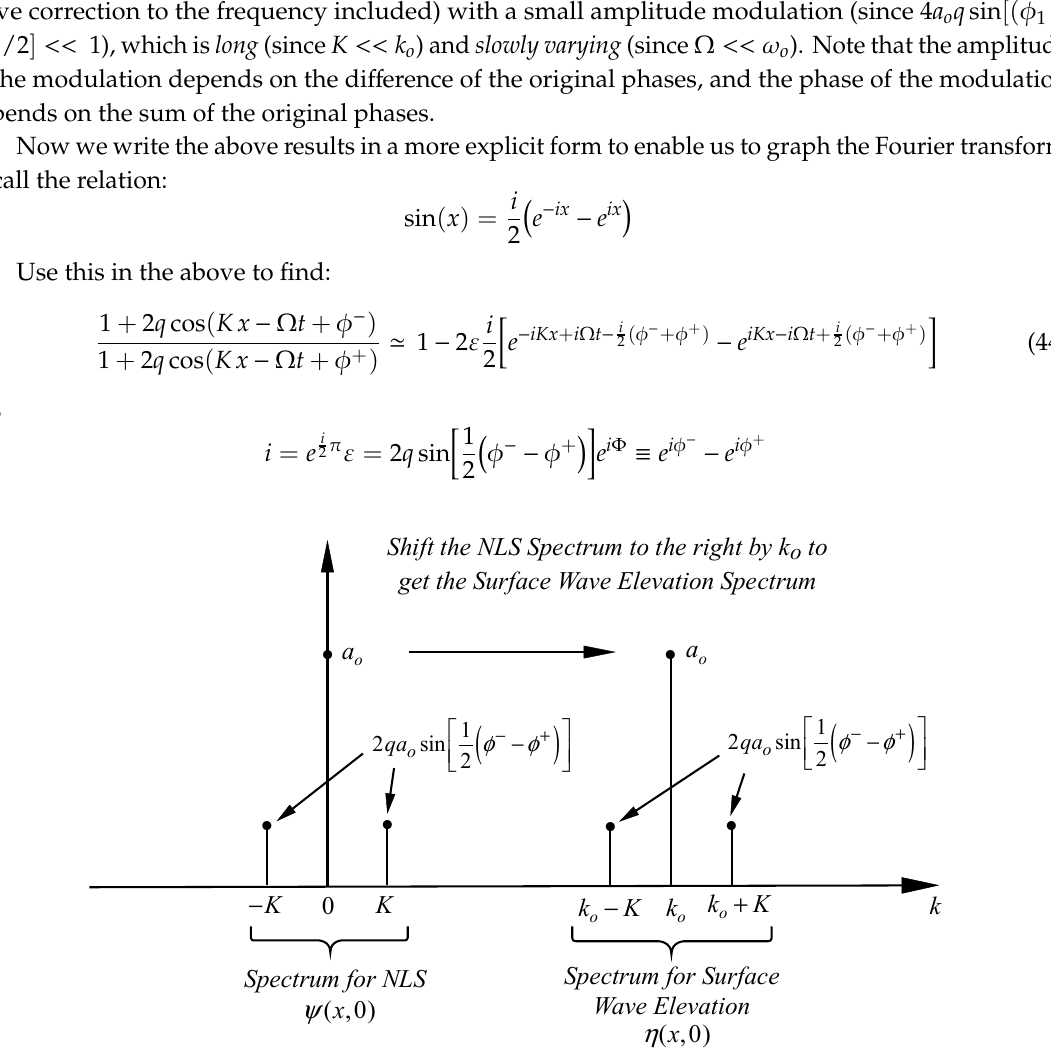
Figure 3. Fourier wavenumber spectrum of the surface wave elevation as found from the modulation spectrum. This case corresponds to the small modulation solution of the Schrödinger equation already shown in Figure 2, where the Fourier modulation spectrum is centered about zero wavenumber. To obtain the Fourier spectrum for the surface wave elevation, one just shifts the modulational spectrum to the right by the carrier wavenumber k o